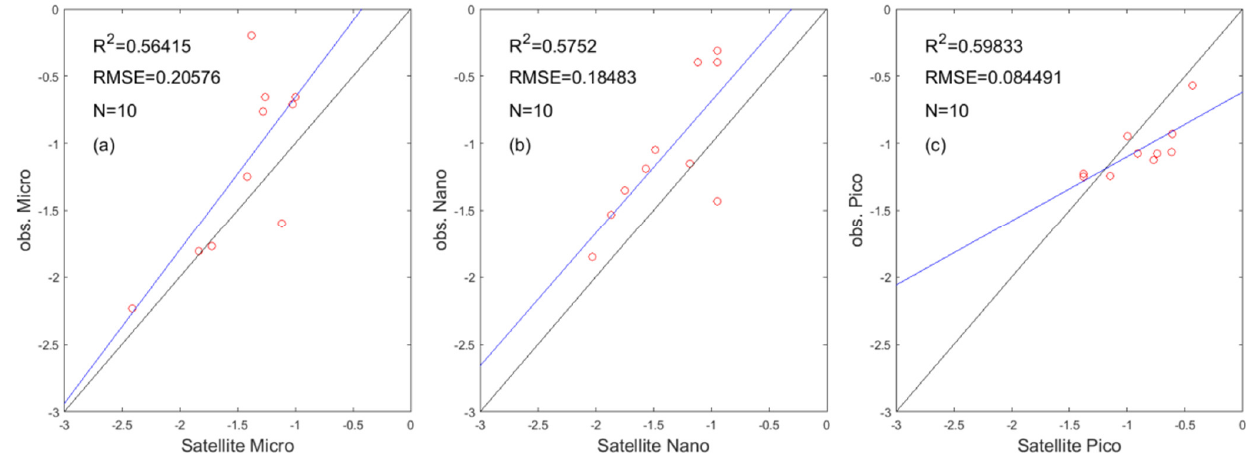
Figure 4. Scatter plots of in−situ versus satellite data: ( a ) micro, ( b ) nano, and ( c ) pico. The solid line is the trendline, and the dotted line is the 1:1 line. The N is the number of samples.